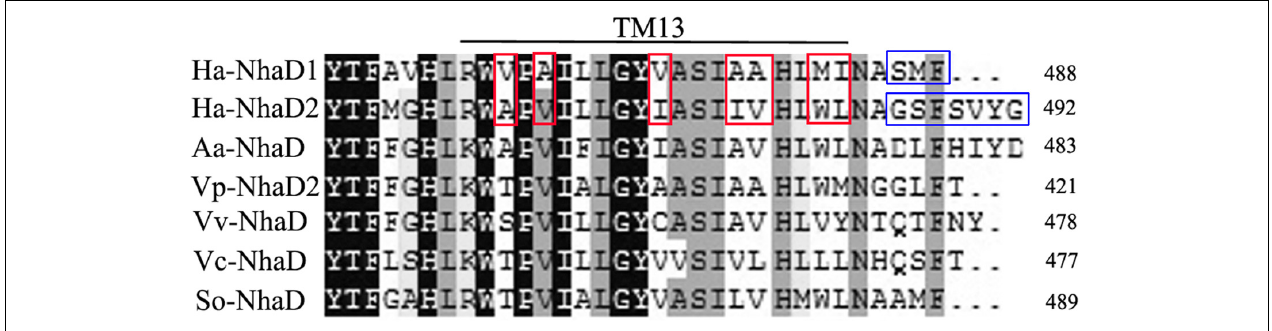
FIGURE 4 | Multiple alignment of the amino terminal sequences of various NhaD homologs by Clustal_X. Residues in blue squares are the replaced residues for chimera N463r-C7 construction; residues in TM XIII for mutation are shown in red squares. Amino acid sequence of NhaD2 was used as a query sequence for BlastP analysis. Homologous sequences from Alkalimonas amylolytica (Aa-NhaD, No. Q56EB3), Vibrio parahaemolyticus (Vp-NhaD), Vibrio vulnificus (Vv-NhaD, No. OJI52092), Vibrio cholera (Vc-NhaD, No. A5F120), and Shewanella oneidensis (So-NhaD, No. Q8EIA8) were selected for alignments.